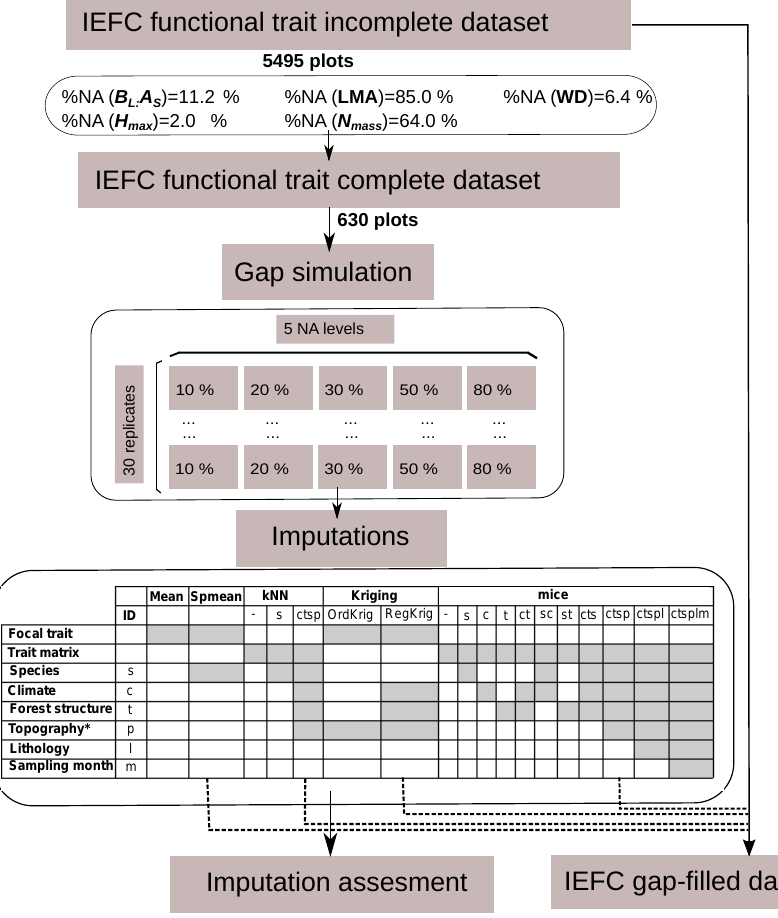
Figure 1. Description of the experimental design. A subset was obtained from the incomplete IEFC trait dataset containing only plots where all functional traits had been measured (complete dataset) to perform the gap simulations and the imputations. Imputation methods are described in terms of the input information used. The selected methods for the final application of imputation methods to obtain a gap-filled IEFC trait dataset are also